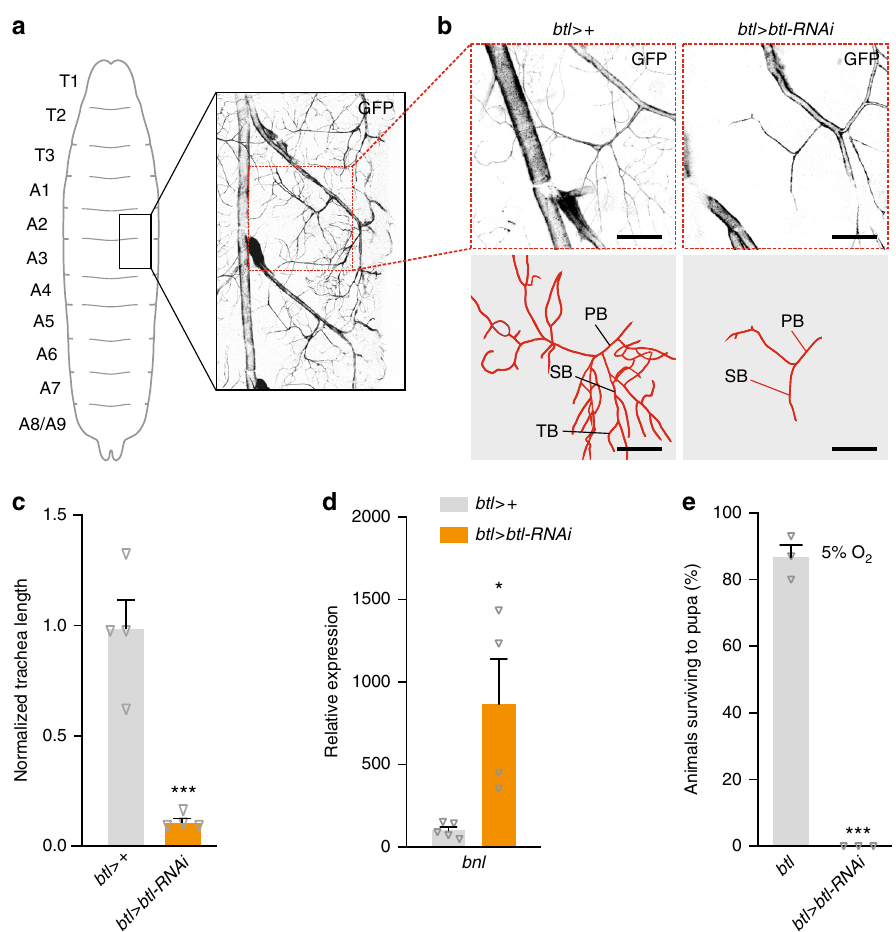
Fig. 4 Airway branching is reduced in breathless -knockdown animals. a Tracheae ramifying to the fat body were measured in larval segments A2/A3, illustrated in overview here. b , c Knockdown of breathless ( btl ) in tracheae leads to a reduction in branching of the terminal tracheal cells of the fat body branch compared with the btl > + control ( btl > crossed to w 1118 ). Representative images ( b ) and quanti fi cation ( c ) of the fat-body branch of larval tracheal terminal cells are shown. Scale bar, 50 µ m. PB, primary branch; SB, secondary branch; TB, tertiary branch. c : n = 4. d Whole-body transcript levels of branchless ( bnl ), encoding the hypoxia-inducible FGF ligand of Btl, is strongly upregulated in larvae with trachea-speci fi c btl knockdown, suggesting that tissues are experiencing hypoxia in these animals. n = 4 – 5. e Loss of btl renders animals unable to survive in a low-oxygen environment (5% O 2 levels), whereas most btl > + controls are able to develop to pupariation. n = 3. Statistics: Student ’ s t -test for pairwise comparisons. * P < 0.05, *** P < 0.001, compared with the control. Error bars indicate SEM. Underlying data are provided in the Source Data fi